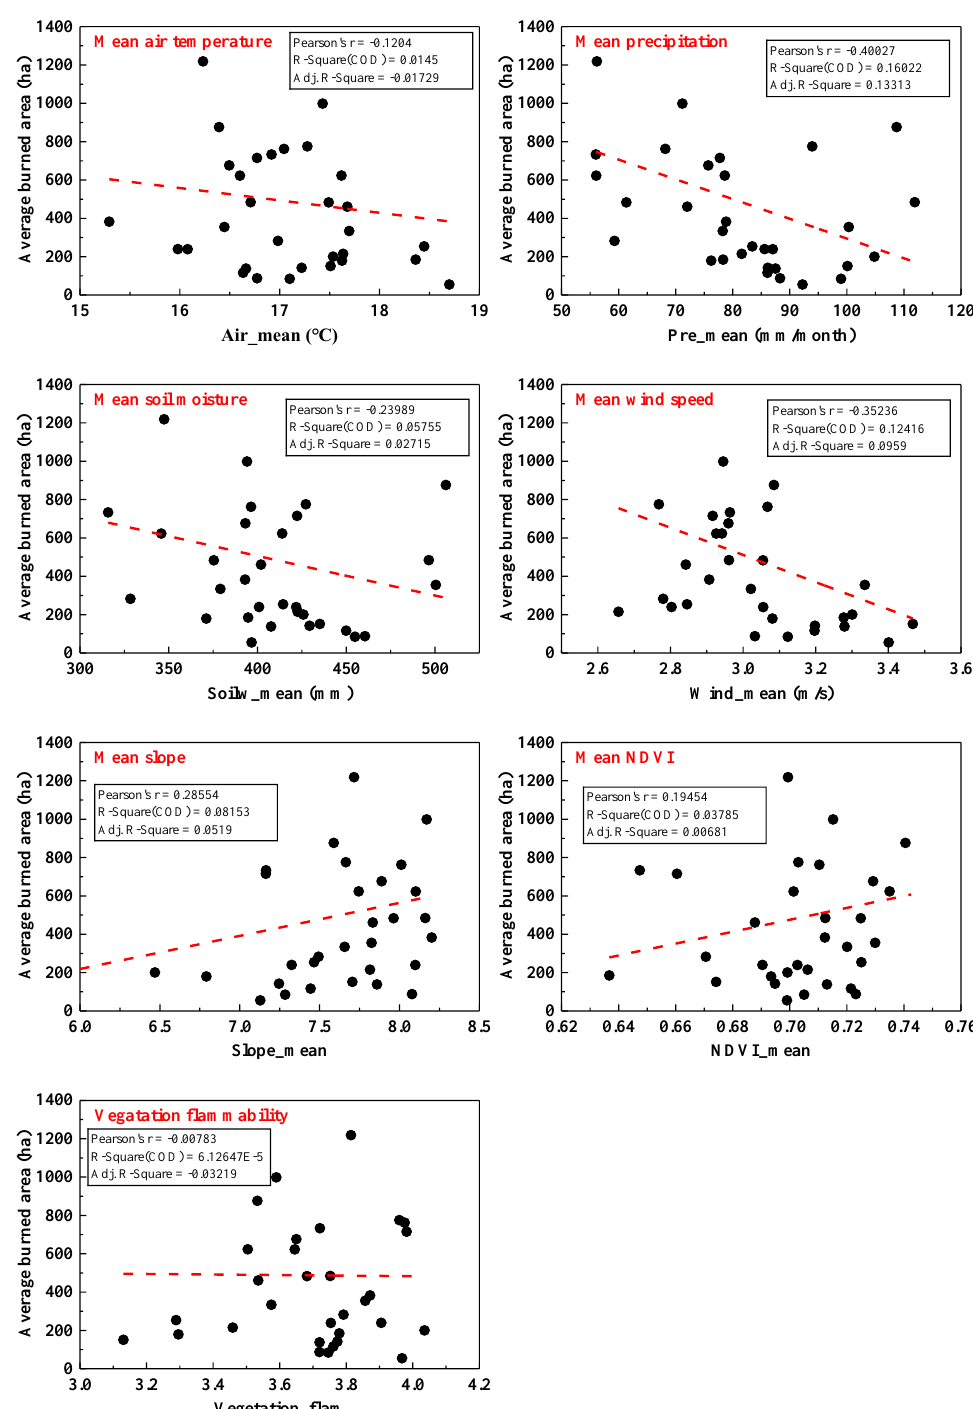
Figure 5. Scatter plot of the area burned by bushfires as a function of seven categories of influencing factors’ variations: mean air temperature (denoted as Air_mean), mean precipitation (denoted as Pre_mean), mean soil moisture (denoted as Soilw_mean), mean wind speed (denoted as Wind_mean), mean terrain slope (denoted as Slope_mean), mean NDVI (denoted as NDVI_mean) and vegetation flammability (denoted as Vegetation_flam).